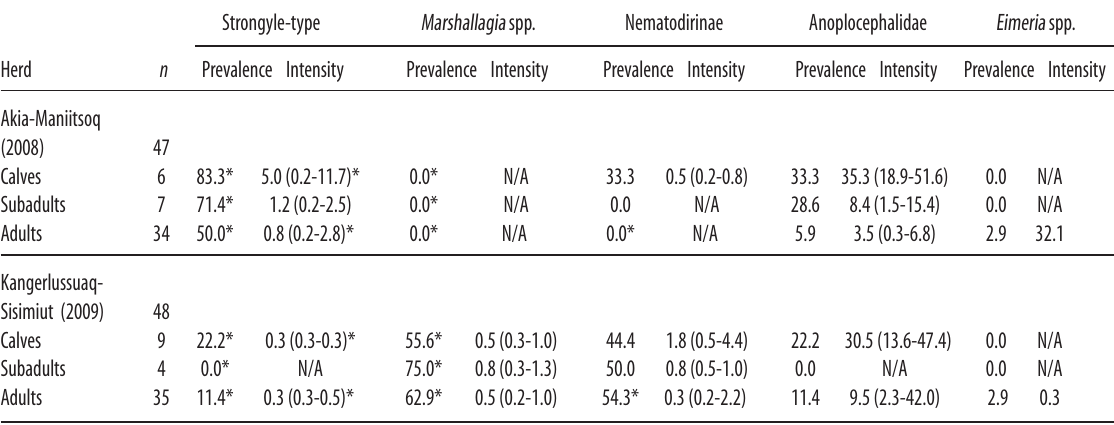
Table 1. Prevalence [% positive samples] and intensity [EPG/OPG; Median (Min. – Max.)] of gastrointestinal parasite eggs and oocysts of fecal samples from animals of the Akia-Maniitsoq and Kangerlussuaq-Sisimiut caribou populations. Significant differences between herds ( p ≤ 0.05), within an age class, are indicated by *, Fisher’s Exact (prevalence) or Wilcoxon (intensity)